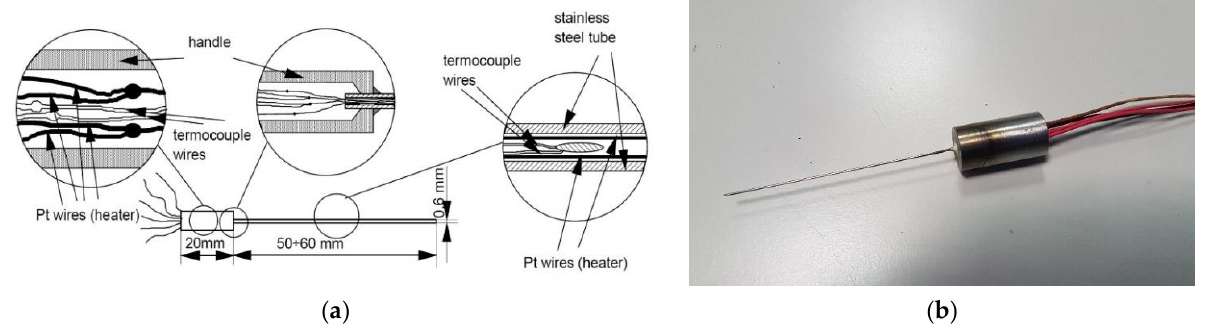
Figure 6. Scheme of the TCP ( a ) and final appearance of the probe ( b ).